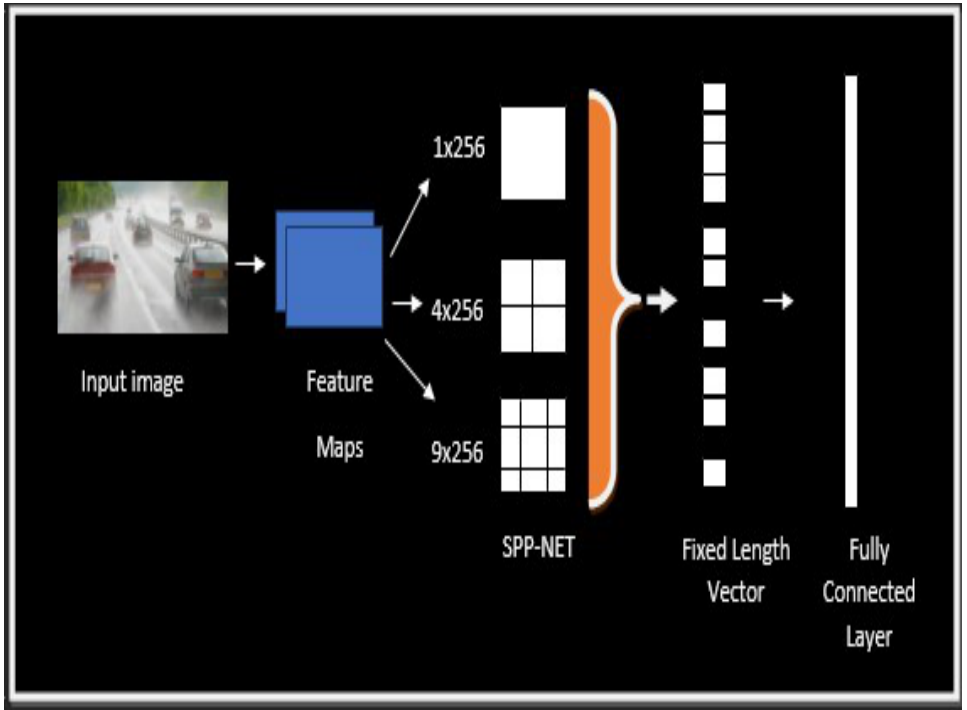
Figure 10. The role of spatial pyramid pooling network: 256 represents the last convolution layer filter